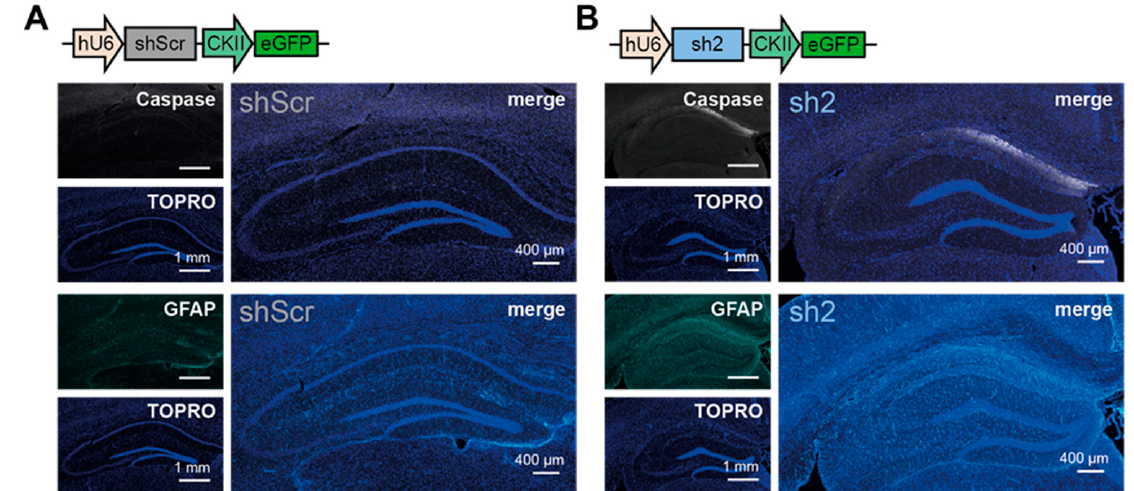
Figure 6. Apoptotic marker expression in dorsal hippocampal CA1 region 5 weeks post-injection of rAAV9-sh2 and control virions. Representative immunofluorescent images showing expression of the apoptosis marker active caspase-3 (Caspase, gray) and astrogliosis-enriched glial fibrillary acidic protein (GFAP, cyan). Animals were injected with ( A ) rAAV9-shScr virions or ( B ) rAAV9-sh2 virions. Animals were sacrificed 5 weeks post-injection. Proteins were stained using specific antibodies combined with fluorescently labeled secondary antibodies. Nuclei were stained with TOPRO (blue). Cartoons of the rAAV-delivered constructs are displayed above the images.